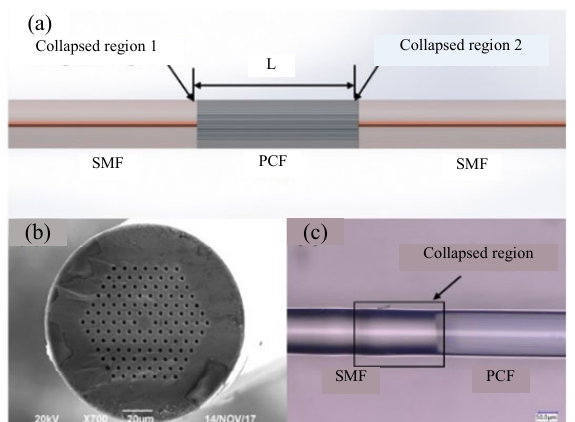
Fig. 1 In-line MZI with the PCF structure (a) schematic diagram of the MZI, (b) scanning electron micrograph (SEM) of the cross section of a LMA-10-PCF, and (c) optical micrograph of the